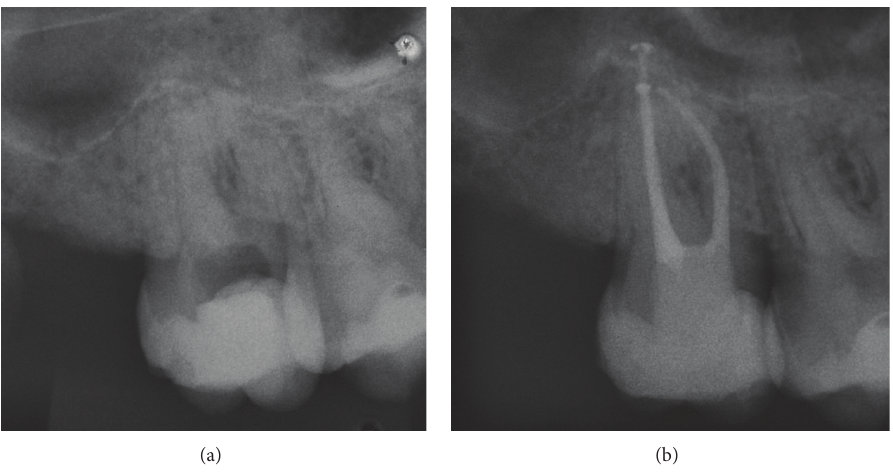
Figure 1: (a) Initial radiograph showing constricted canals mainly in the buccal roots. (b) Final radiograph.